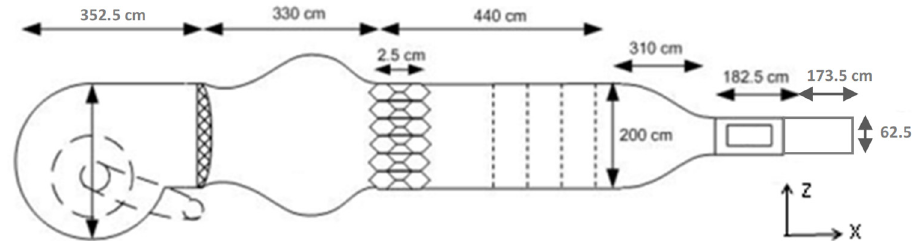
Figure 3. The wind tunnel dimensions in cm.